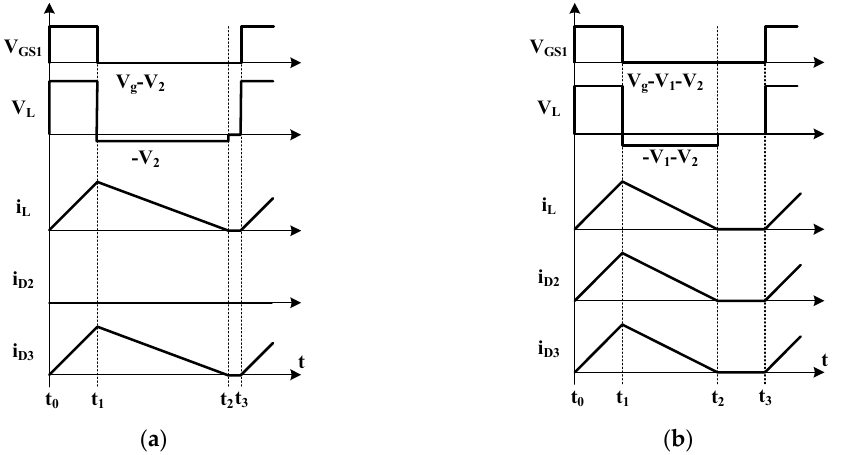
Figure 1. Circuit configuration of the proposed converter.